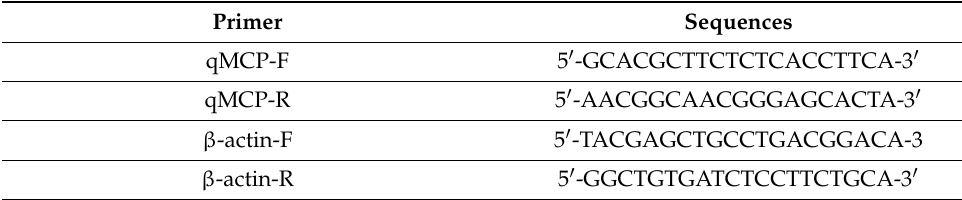
Table 1. Primers for detecting SGIV infection by